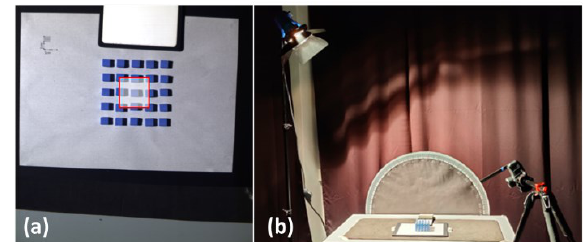
Figure 4 . Experimental imaging configuration for Dataset #2: (a) an example of the surface with 1cm height cubes, the red polygon represents the repetitive pattern’s selected region. (b) experimental setup for 60 ° view zenith angle and a pattern with 4cm height